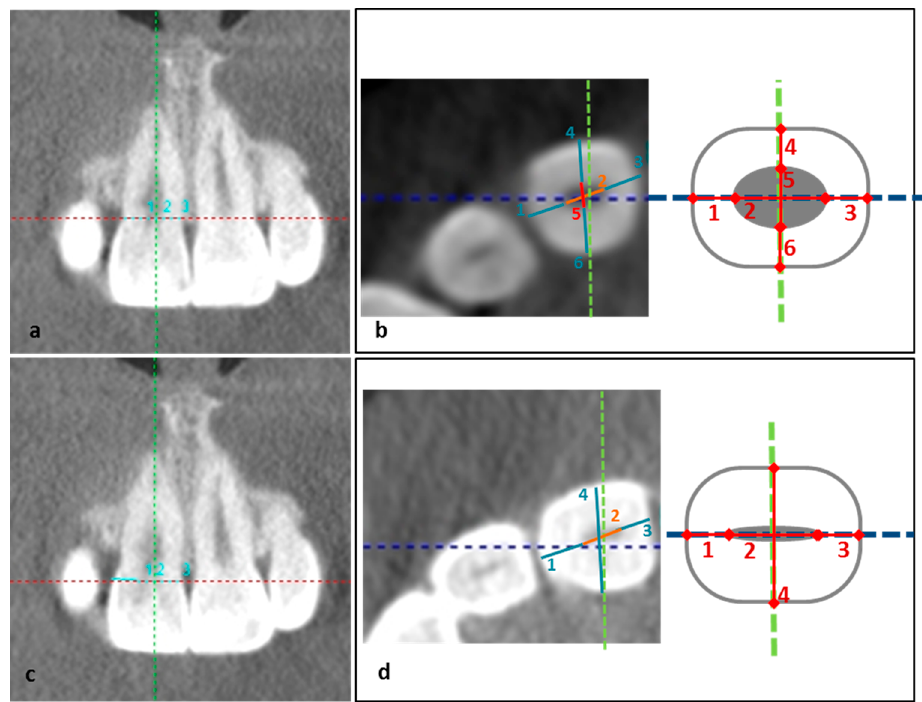
Figure 2. ( a ) Coronal measurements at cementoenamel junction level: mesiodistal tooth length (cce_MDTL, sum of the values 1+2+3), mesiodistal pulp length (cce_MDPL, value 2); ( b ) axial measurements at cementoenamel junction level: mesiodistal tooth length (ace_MDTL, sum of the values 1+2+3); ( c ) coronal measurements at pulp horn level: mesiodistal pulp length (cph_MDPL, value 2), palatovestibular tooth length (ace_PVTL, sum of values 4+5+6), palatovestibular pulp length (ace_PVPL, value 5) and ( d ) axial measurements at pulp horn level: mesiodistal tooth length (aph_MDTL,sum of the values 1+2+3), mesiodistal pulp length (aph_MDPL, value 2), palatovestibular tooth length (aph_PVTL, value 4).